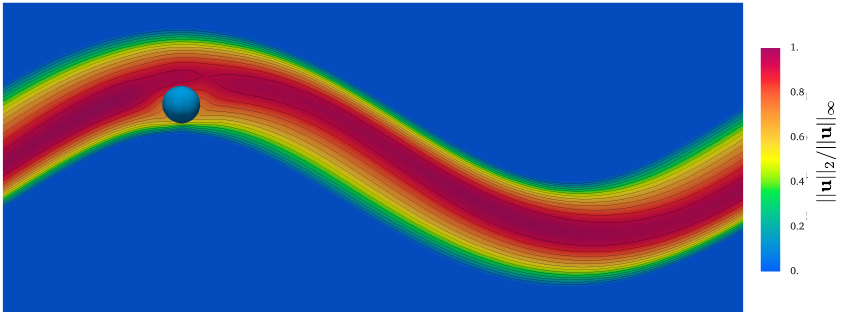
Figure 24. Snapshot of || u || 2 / || u || ∞ for Re = 115 and ( x p / R c , y p / R c , z p / R c ) = ( 1,0.5,0 ) as the initial position of the particle in the